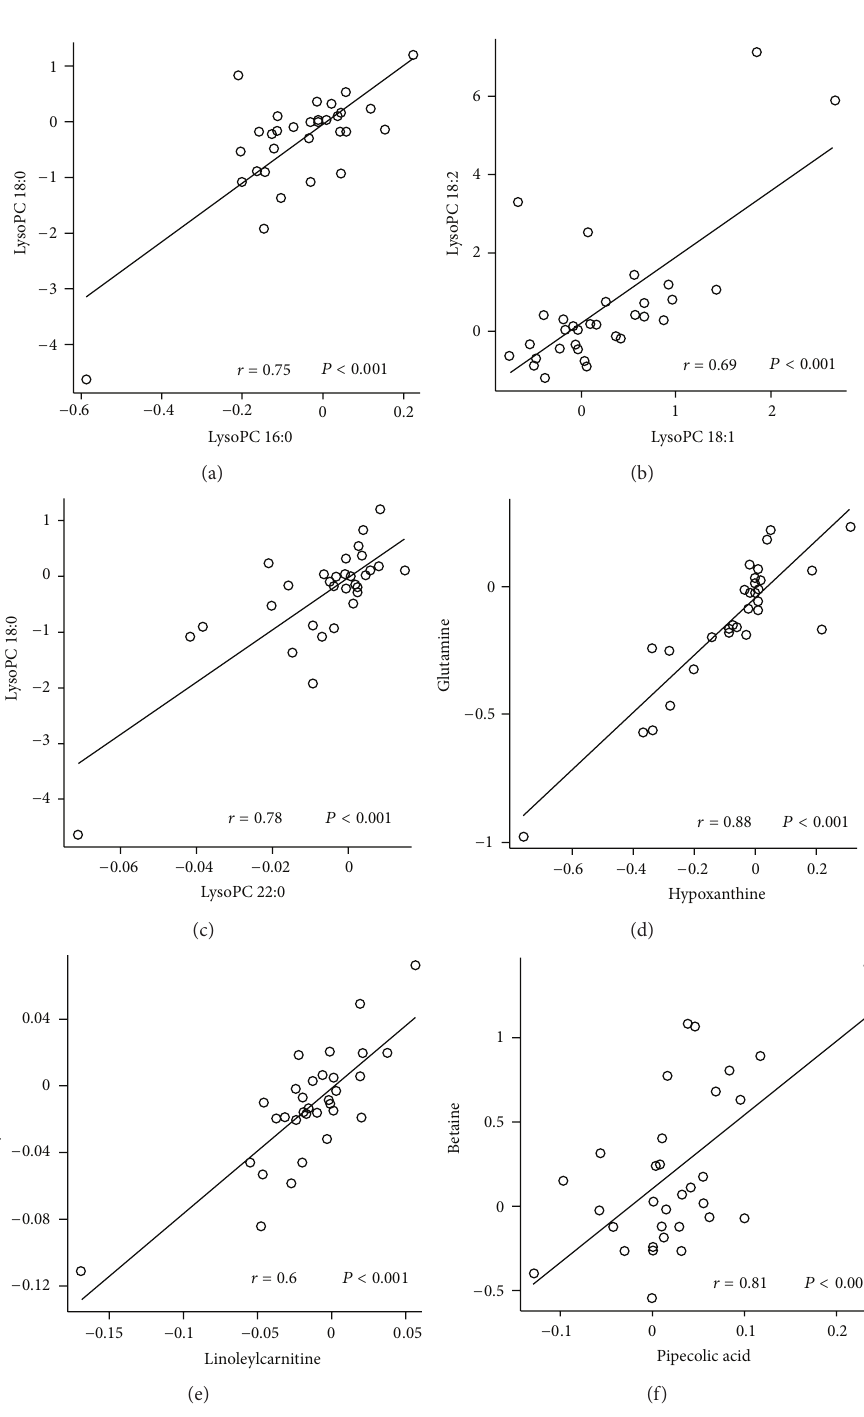
Figure 4: Relationship between the changes in the major metabolite levels by Pearson’s correlation analysis. 𝑟 , correlation coefficient. The changes in lysophosphatidylcholine (lysoPC) 16:0 levels were positively related to those of lysoPC 15:0 ( 𝑟 = 0.90 , 𝑃 < 0.001 ) and lysoPC 18:0 ( 𝑟 = 0.76 , 𝑃 < 0.001 ), while that of lysoPC 18:0 was closely related to that of lysoPC 15:0 ( 𝑟 = 0.77 , 𝑃 < 0.001 ). The change in the lysoPC 18:2 level was closely related to that of lysoPC 18:0 ( 𝑟 = 0.81 , 𝑃 < 0.001 ), while that of lysoPC 18:1 was related to that of lysoPC 18:2 ( 𝑟 = 0.69 , 𝑃 < 0.001 ). The change in the proline level was related to those of tryptophan ( 𝑟 = 0.53 , 𝑃 < 0.001 ) and phenylalanine ( 𝑟 = 0.55 , 𝑃 < 0.001